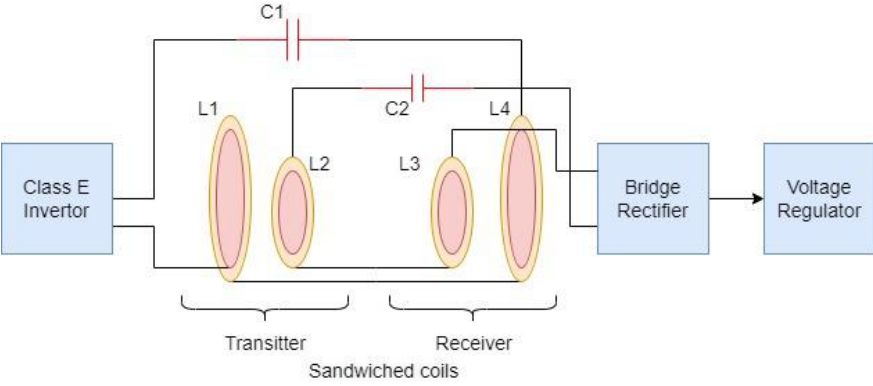
Figure 2. Sandwiching arrangement of coils on transmitter and receiver of WPT system.